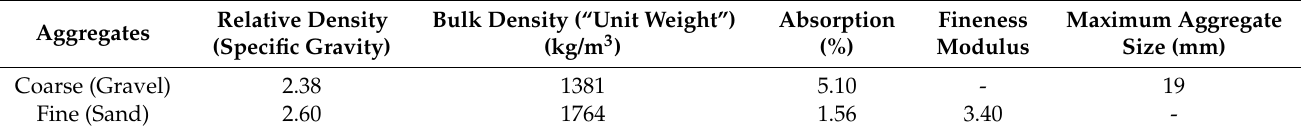
Table 2. Physical characteristics of the aggregates.